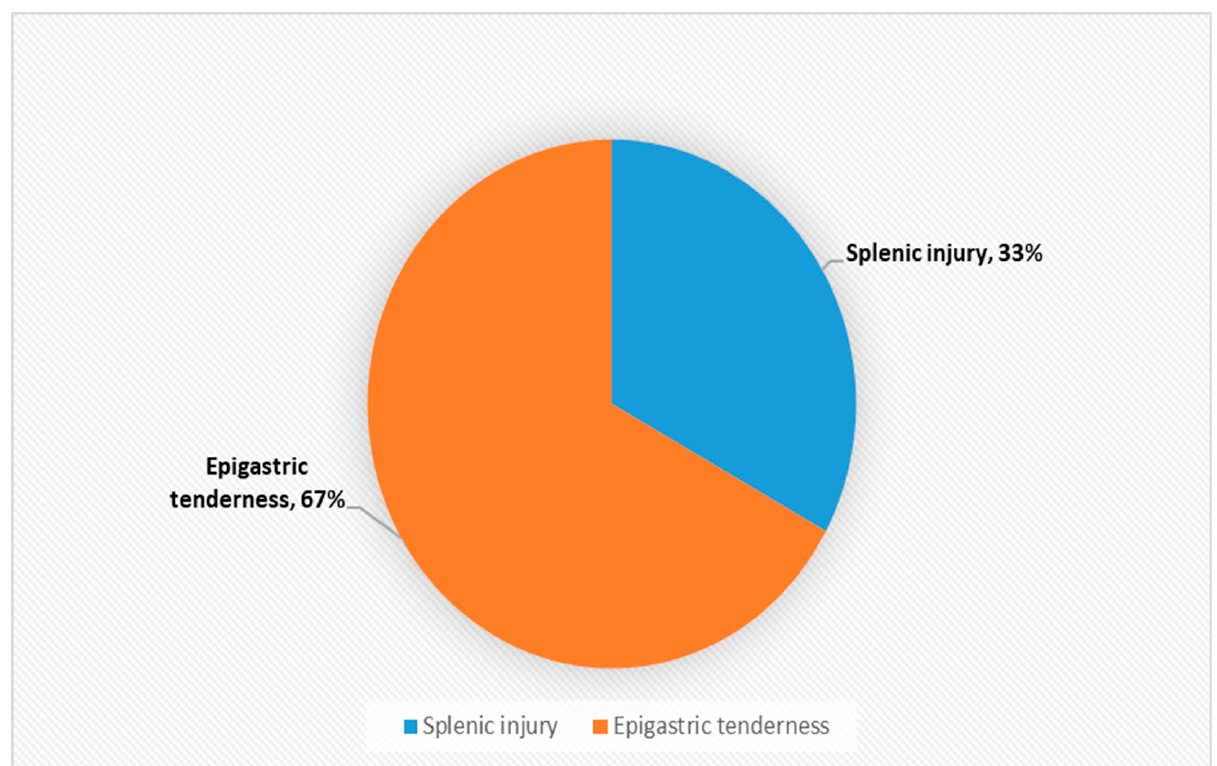
Figure 6. Composition of gastrointestinal injuries as a % ( n = 3).